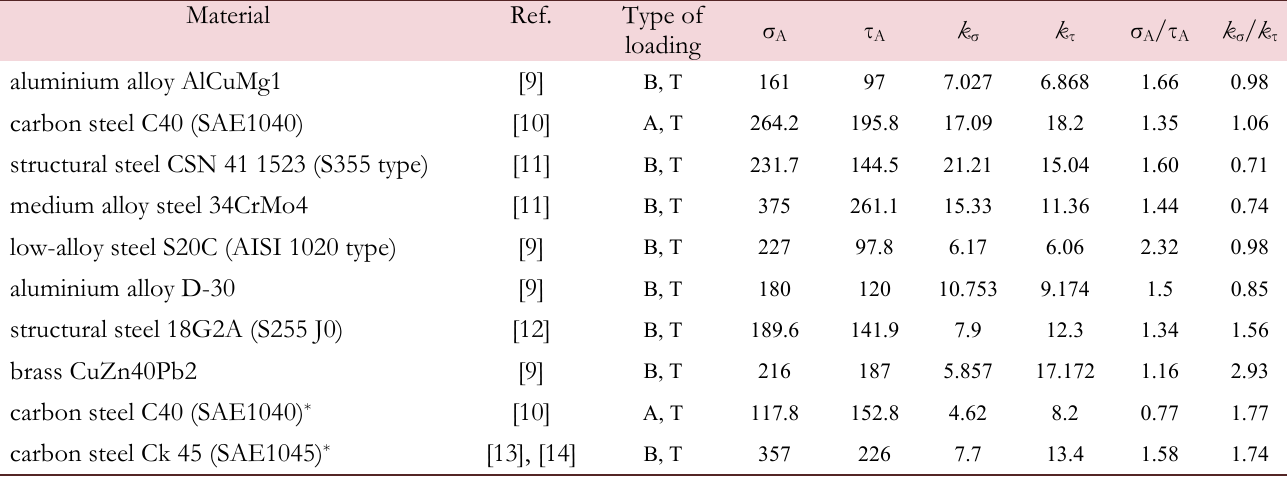
Table 1: Fatigue parameters for several plain materials or notched specimen). * V-notched ( R =0.5